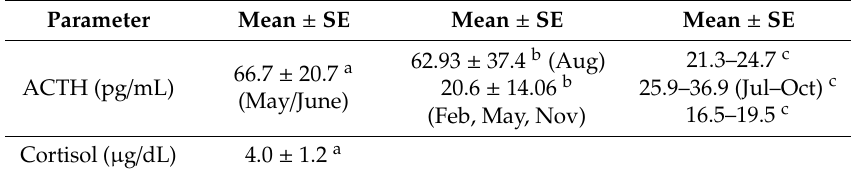
Table 4. Concentrations of ACTH and cortisol in donkeys reported in